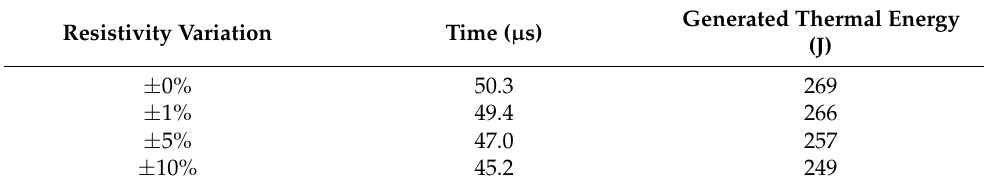
Table 2. FDTD-calculated time interval and generated thermal energy until the voltage across the MOV drops to zero.